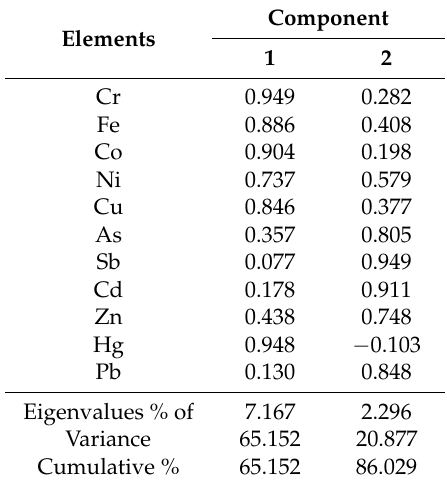
Table 6. Rotated component matrix of trace elements in soil.